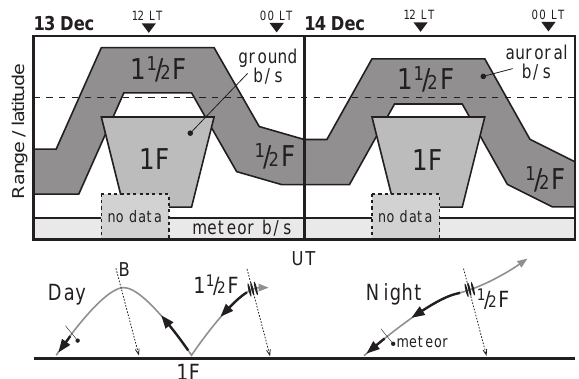
Fig. 3. A schematic indicating our interpretation of the ori- gin of backscatter during the 13 and 14 December 2002. Also shown are the assumed propagation modes that give rise to the ob- served backscatter, for daytime and nighttime ionospheric condi- tions. Grey rays show the out-going radar signal, with black arrows showing regions of backscatter, including meteor, ground, and iono- spheric backscatter. Ionospheric scatter is only observed where ∼ 15 m field-aligned irregularities are present. forward-scatter for the intersection cell (dotted curve); for clarity of presentation the data have been averaged to one tenth of their original temporal resolution. These values are the power measured when the radar is operating in the 45 km mode; we add a correction factor of + 20 log